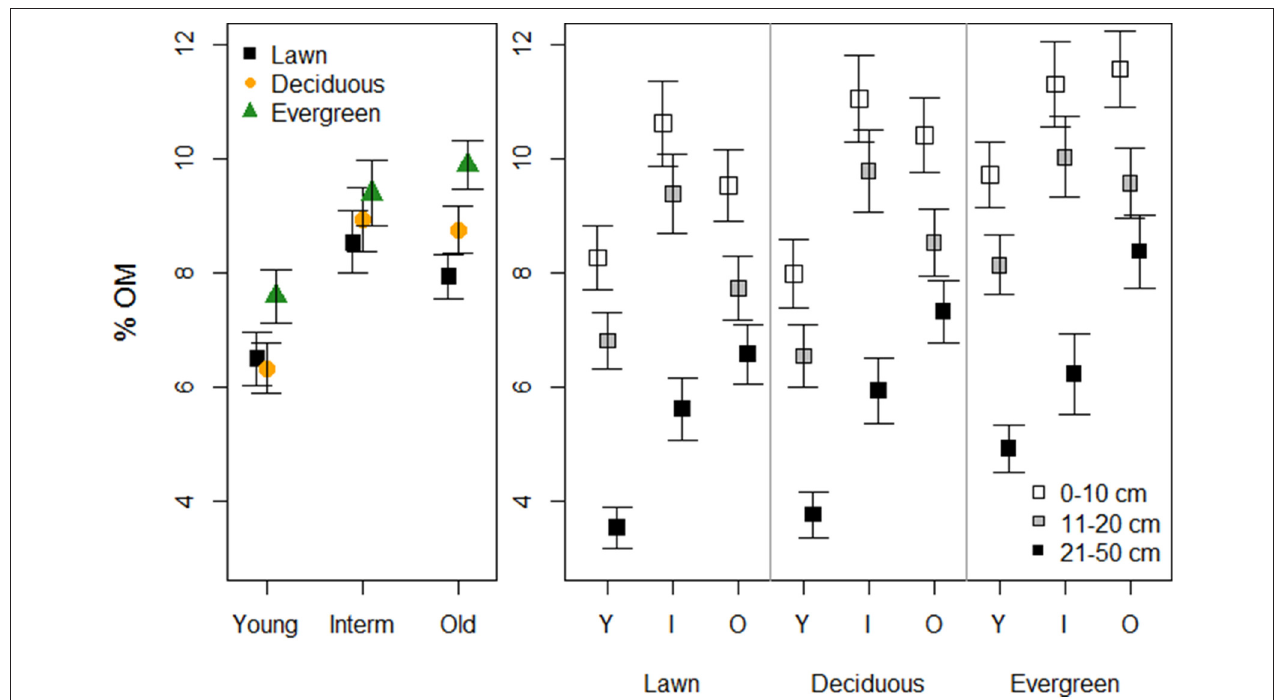
FIGURE 2 | The effects of plant functional groups and park age on soil organic matter concentrations. Predicted means ± SE values are presented. The panel on the left presents data with the three depth intervals pooled, while in the right panel data are shown for each depth interval